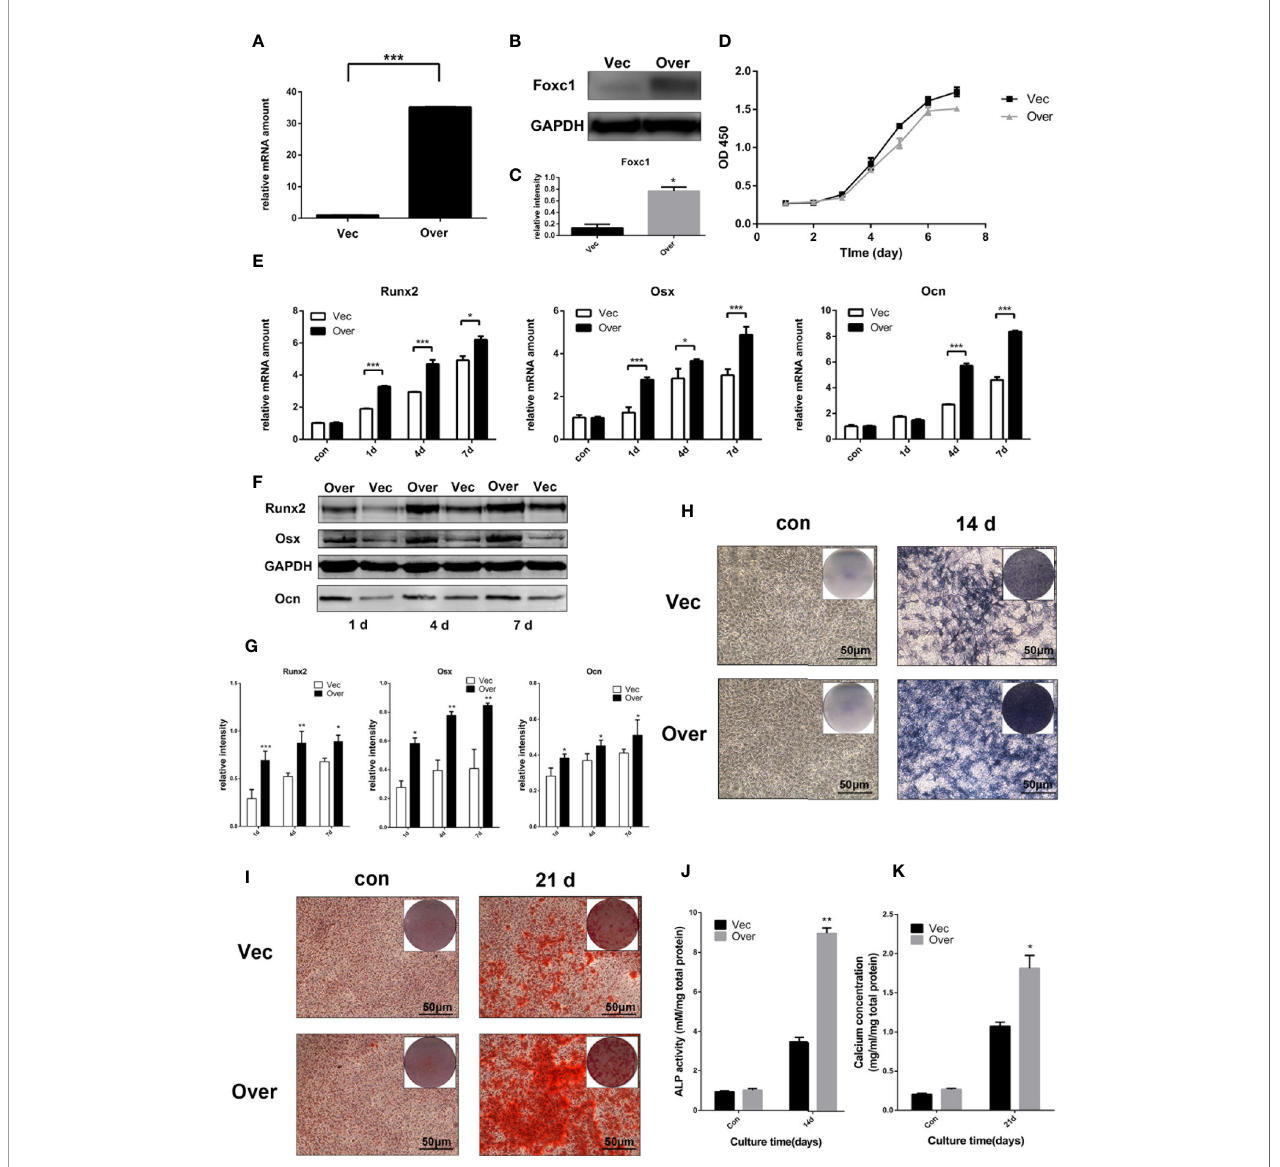
FIGURE 2 | Foxc1 overexpression stimulated osteogenic differentiation induced by intermittent PTH treatment in vitro . (A) mRNA expression level of Foxc1 in Lv- vector and Lv-Foxc1 MC3T3-E1 cells at 48 h after transfection. (B, C) Protein expression level and quantitative analysis of Foxc1 at 48 h after transfection. (D) Cell proliferation rate in Lv-vector and Lv-Foxc1 MC3T3-E1 cells. (E) mRNA expression levels of the osteogenic markers, Runx2, Osx and Ocn on the 1st day, 4th day, and 7th day after exposed to intermittent PTH treatment. (F, G) Protein expression level and quantitative analysis of the osteogenic markers, Runx2, Osx, and Ocn on the 1st day, 4th day, and 7th day after exposed to intermittent PTH treatment. (H, J) ALP staining and activity in Lv-Foxc1 and Lv-vector MC3T3-E1 cells after 2 weeks of intermittent PTH treatment. (I, K) Alizarin red S staining and calcium concentration in Lv-Foxc1 and Lv-vector MC3T3-E1 cells after 3 weeks of intermittent PTH treatment. (I, K) . Scale bar = 50 m m. * p < 0.05, ** p < 0.01, *** p <